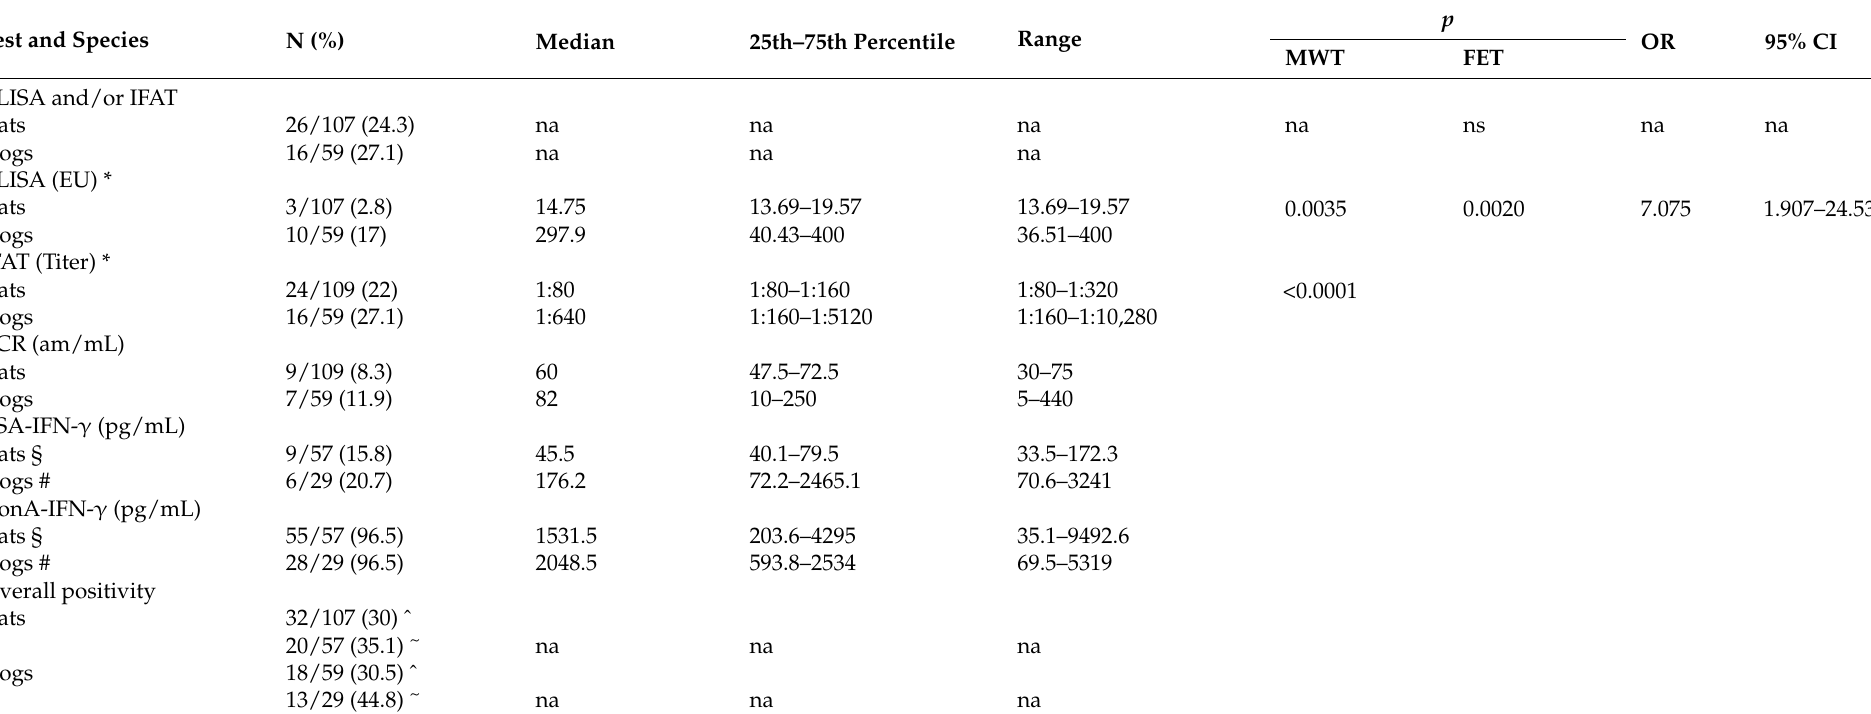
Table 2. Number and percentage values of dogs and cats positive to different diagnostic tests for L. infantum , median, 25th and 75th percentiles and range of results for different